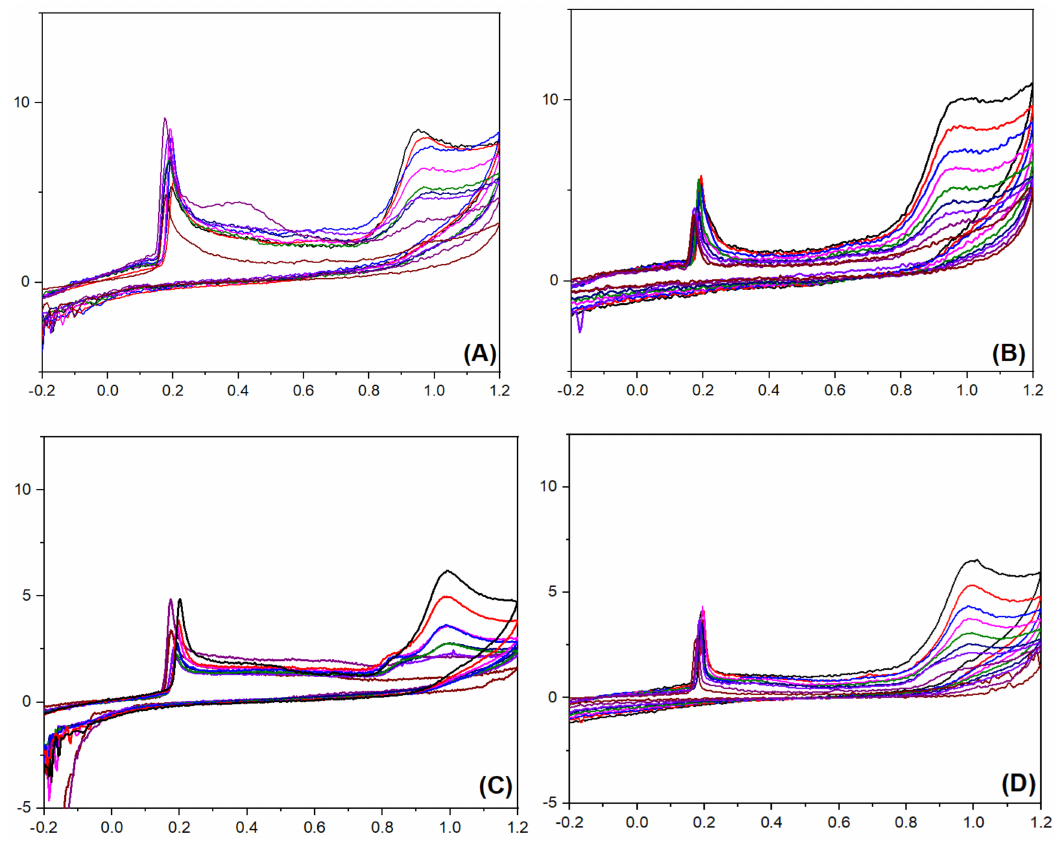
Figure 9. Detection of 2-NP with ( A ) Ag@PANI and ( B ) Ag@P-CA electrode materials. Detection of 4-NP with ( C ) Ag@PANI and ( D ) Ag@P-CA electrode materials. The Y-axis represents current density ( µ A.cm − 2 ), and X-axis represents the potential (V). The CV analysis of the composites was carried out at a scan rate of 50 mV · s − 1 and a potential range from − 600 to 1200 mV using the three-electrode system in PBS-7 buffer solution (pH = 7) and 298